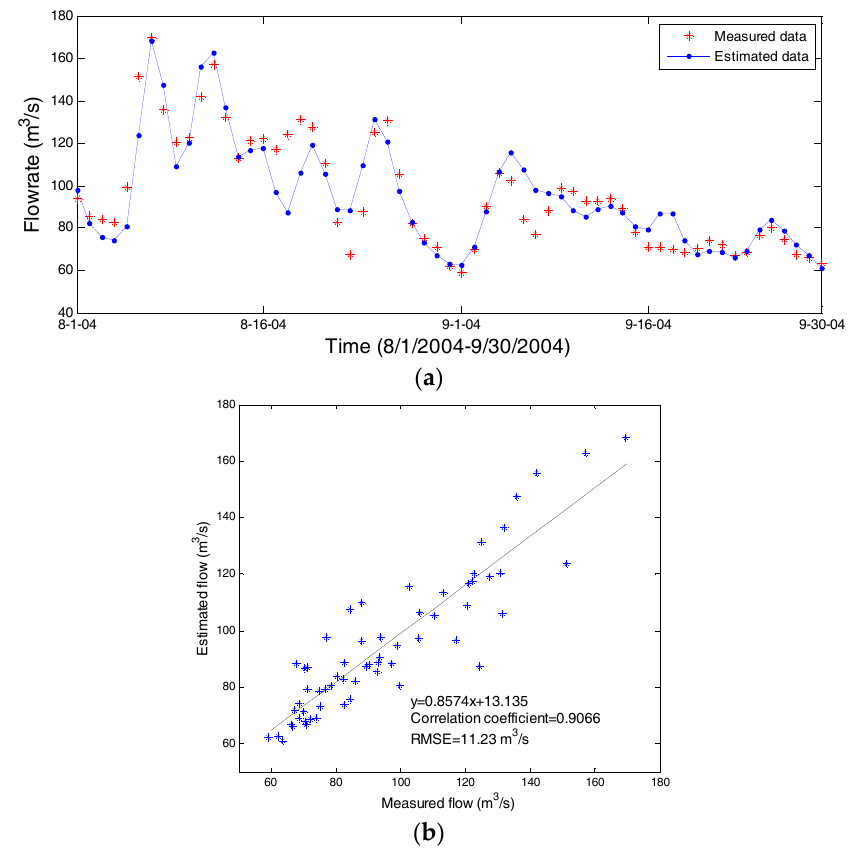
Figure 8. Comparison of measured and estimated flows at Yingluoxia station during the model calibration period from 1 August to 30 September 2004: ( a ) stream flow; ( b ) correlation.